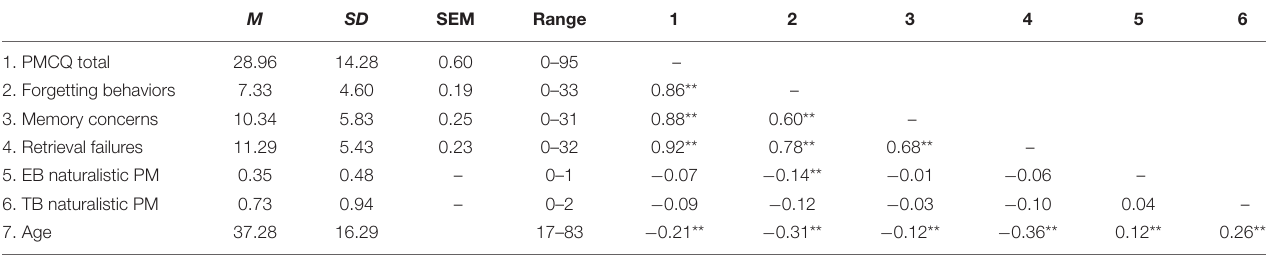
TABLE 3 | Relationships between the PMCQ, its subscales, and performance-based PM tasks. M SD SEM Range